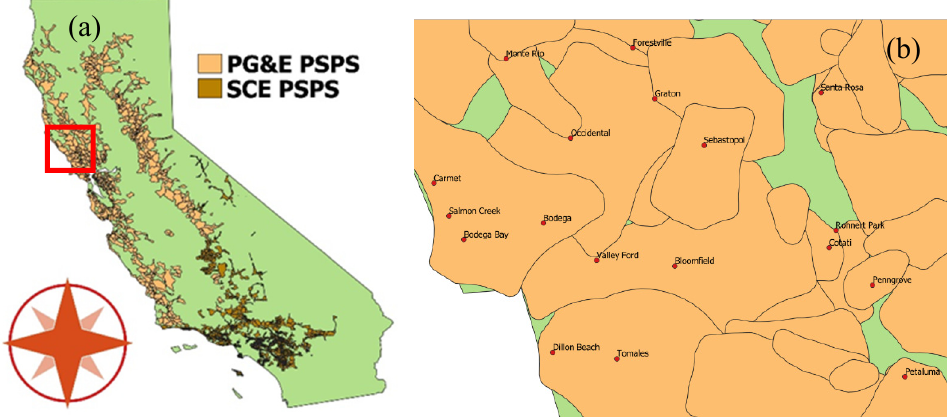
Figure 2. Cities under Public Safety Power Shutoff (PSPS) zones with Tier 2 (Elevated) or Tier 3 (Extreme) California Public Utilities Commission (CPUC) Fire-Threat; ( a ) complete extend ( b ) zoom-in to selected red square.